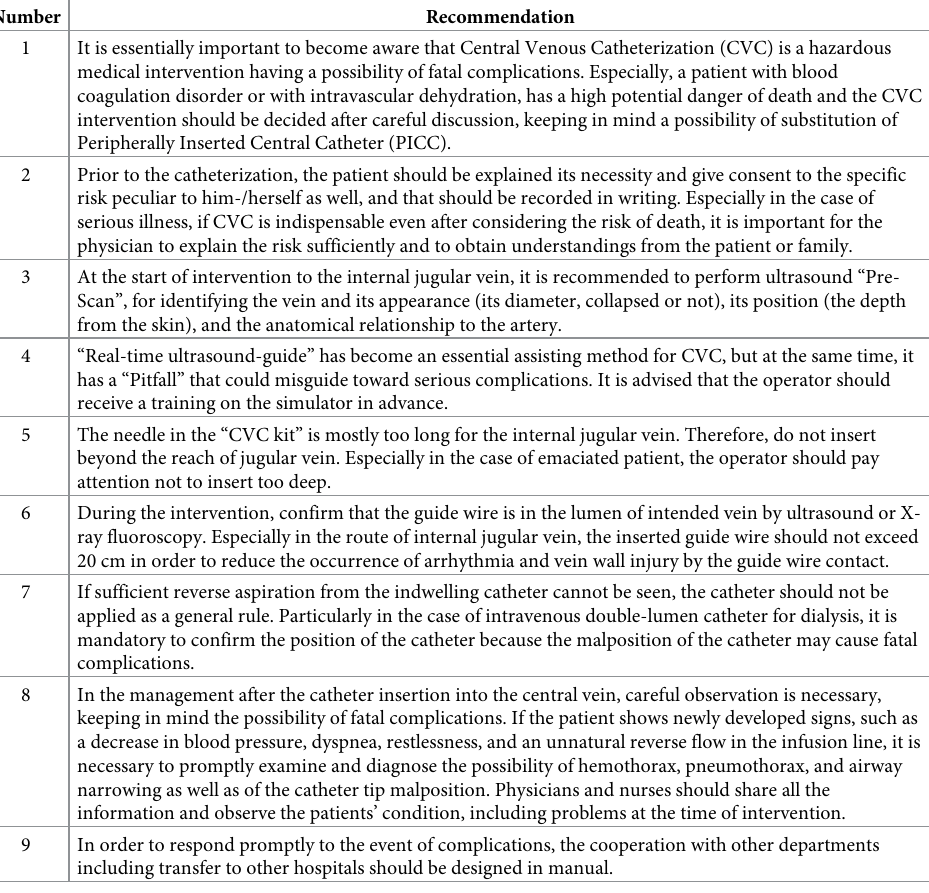
Table 1. Recommendations for the prevention of recurrence of medical accidents (number 1)–analysis of deaths related to the complications of “central venous catheterization”: First report �